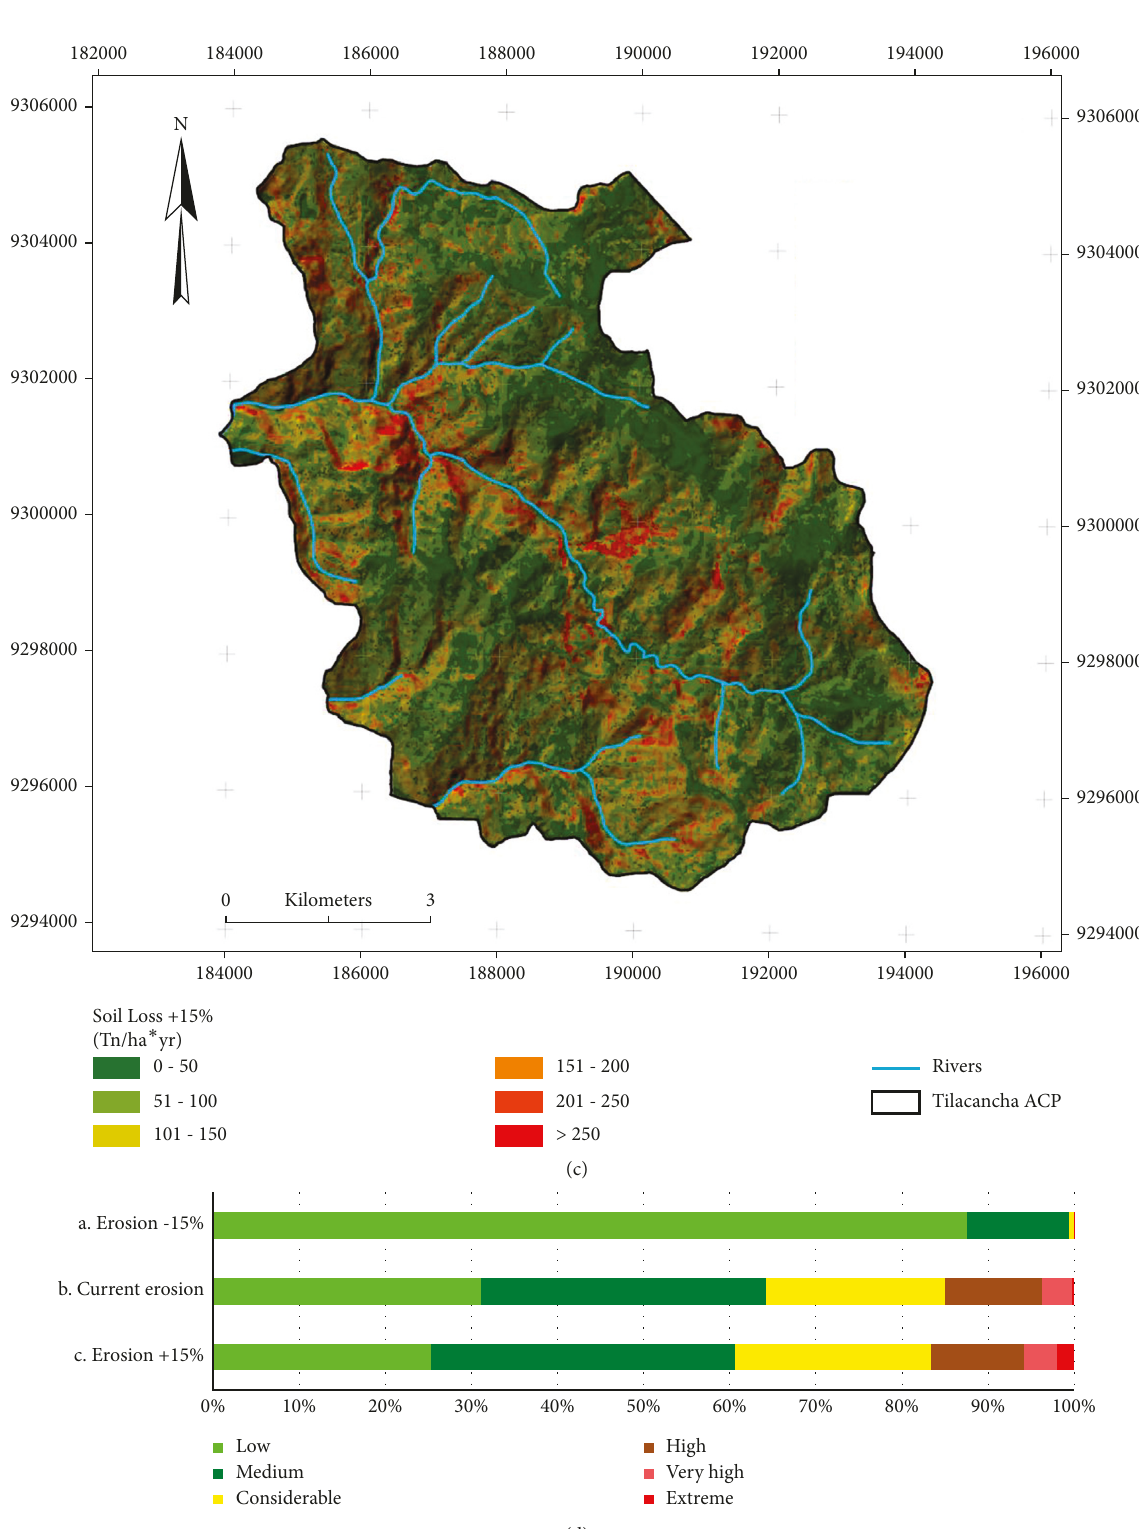
Figure 8: Precipitation maps for erosivity factor: (a) observed annual precipitation, (b) precipitation with a 15% decrease in the coefficient of variation of the historical data group, and (c) precipitation with a 15% increase in the coefficient of variation of the historical data group for the